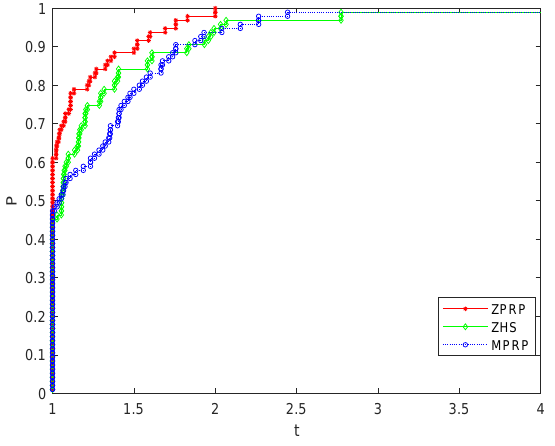
Figure 4. The number of